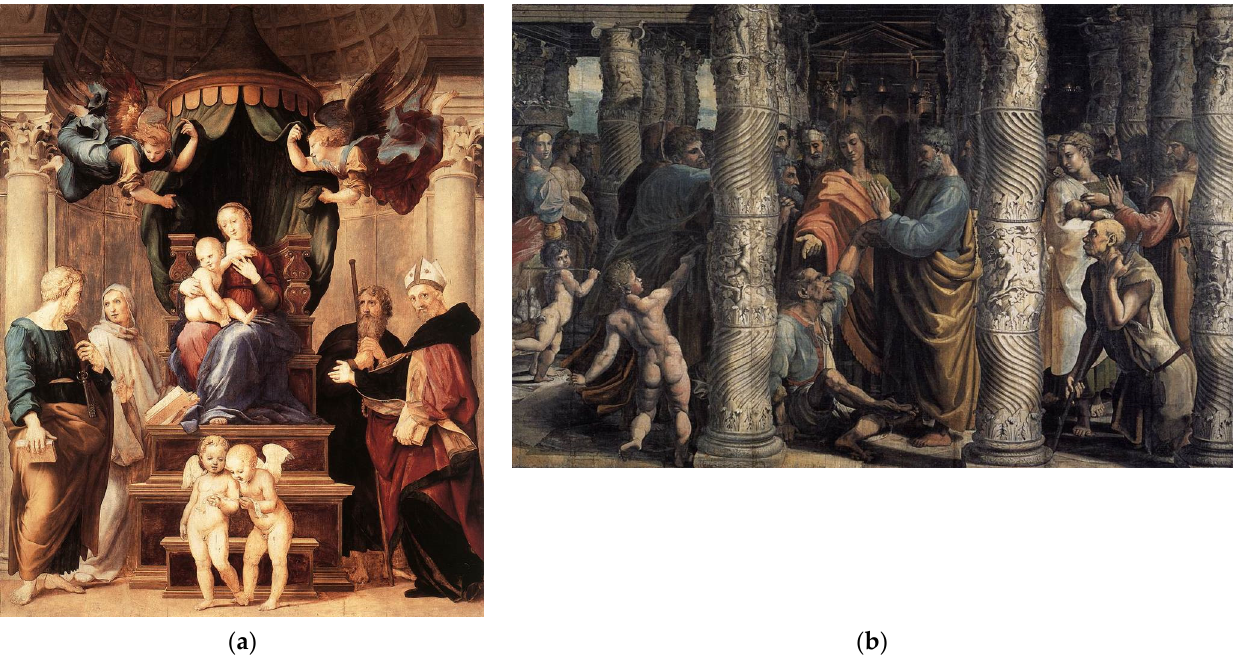
Figure 7. Raffaello, ( a ) The Madonna of the Baldacchino, 1506–1508, Galleria Palatina, Florence; ( b ) The Healing of the Lame, 1515, Victoria and Albert Museum, London. ( b ) The Healing of the Lame, 1515, Victoria and Albert Museum,